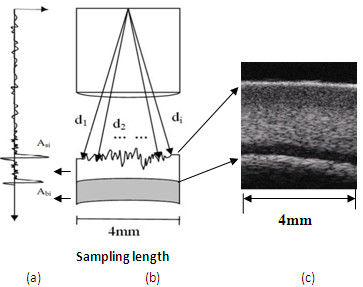
Schematic of calculation of ultrasound roughness index (URI). (a) Ultrasound RF signal reflected from the articular cartilage tissue; (b) Schematic of the scanning scope of ultrasound probe; (c) An ultrasound microscopic image of cartilage tissue.